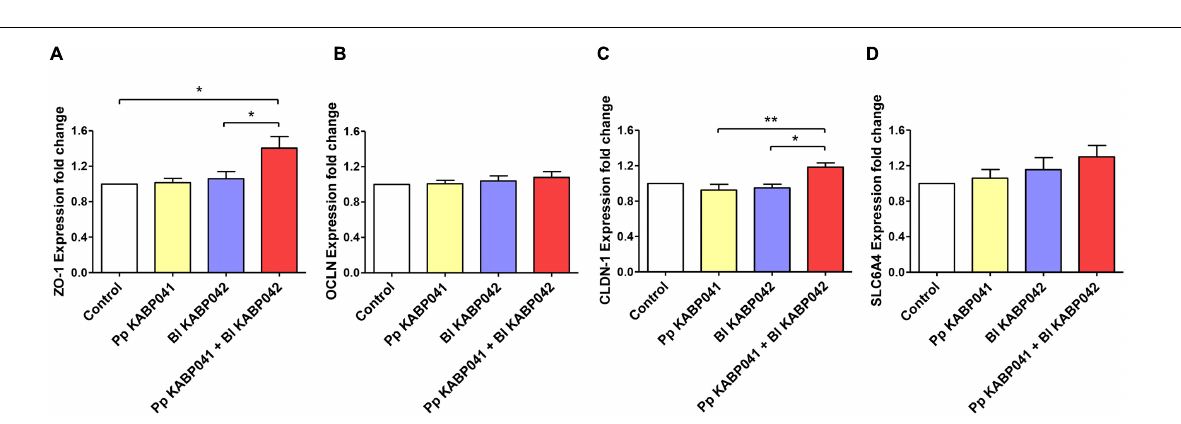
FIGURE 2 | Gene expression of Caco-2 genes (A) ZO-1, (B) OCLN, (C) CLDN-1 and (D) SLC6A4 after co-culturing with P. pentosaceus KABP041 (Pp KABP041), B. longum KABP042 (Bl KABP042) and with a mixture 1:1 of both strains (Pp KABP041 + Bl KABP042). Control condition without bacteria was set at level 1. Statistical differences were assessed by one-way ANOVA followed by Bonferroni’s Multiple Comparison test. * p < 0.05; ** p <